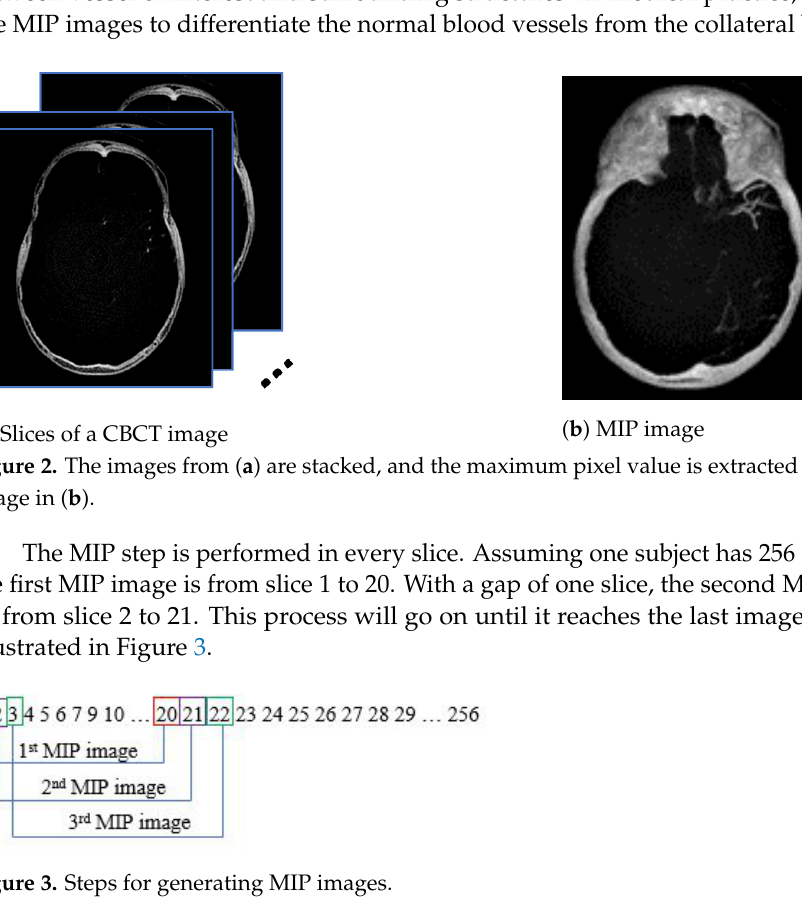
Figure 3. Steps for generating MIP